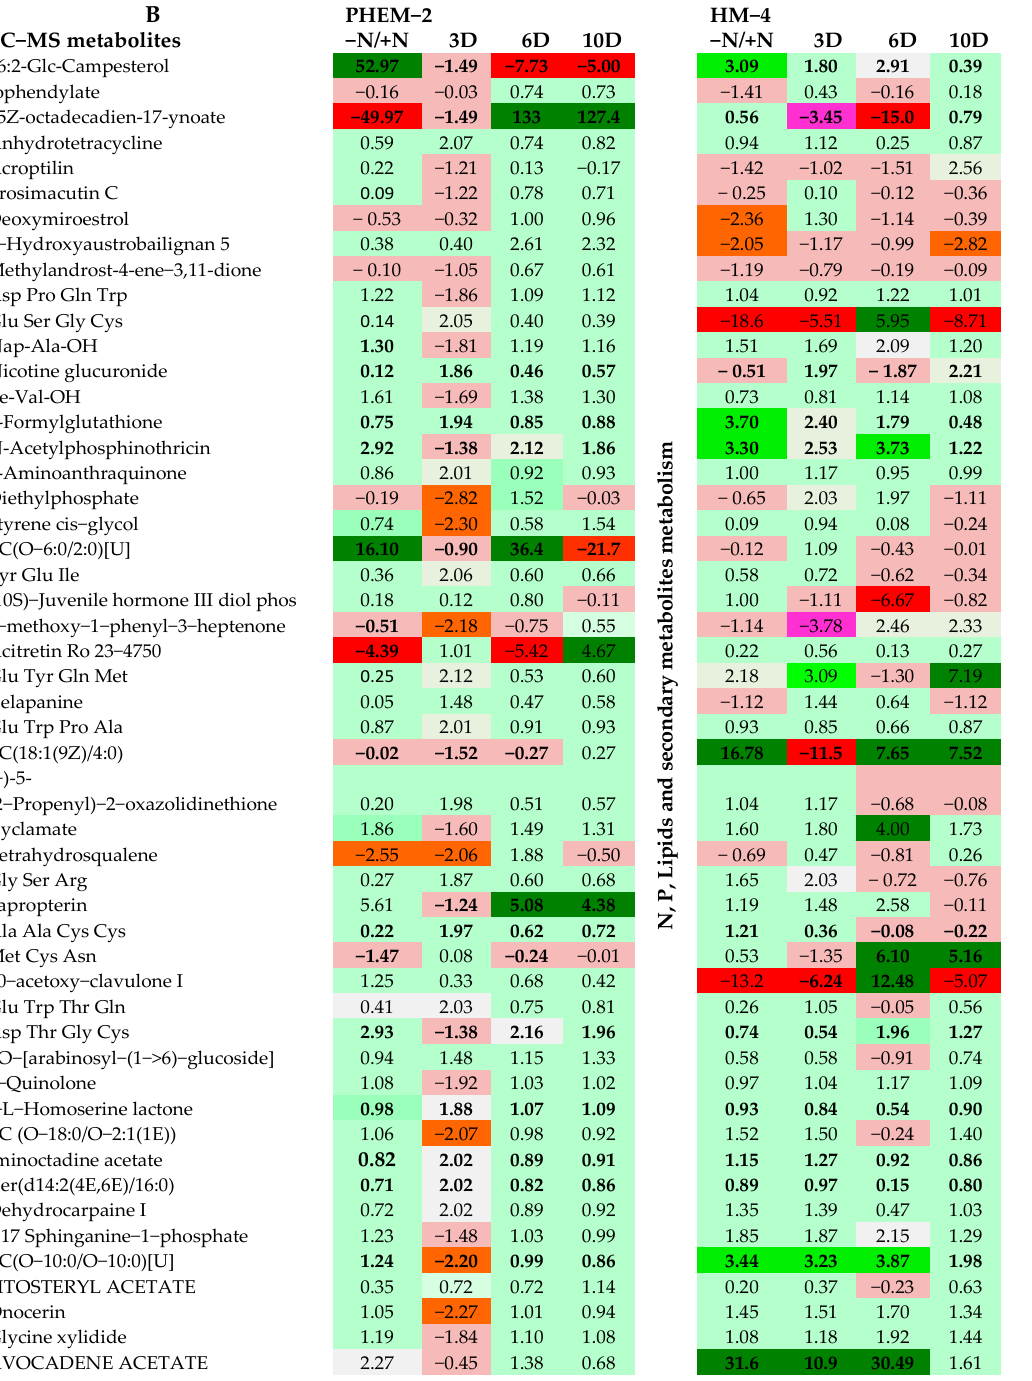
Figure 3. Metabolic responses to N deficiency of low-N tolerant (LNT; PEHM-2) and low-N sensitive (LNS; HM-4) genotypes. ( A ) Root metabolites and ( B ) leaf metabolites. The calculated data shown above exhibit a log transformed fold change (0.05 mM/4.5 mM N) of selected leaf metabolites detected by LC–MS in low-N (0.05 mM), sufficient-N (4.5 mM) and recovery (3DR, 6DR and 10DR) samples. The level of significance between sufficient-N (4.5 mM) and low-N (0.05 mM) treatments was tested by the Student’s t -test ( p -value < 0.05). Significantly changed metabolites in various groups are represented in the bolded form. Upregulation or downregulation of metabolites is indicated with the help of color bar scale, upregulated (green) or downregulated (red), in the metabolite logarithmic fold change, as indicated in the color index ( n = 6).